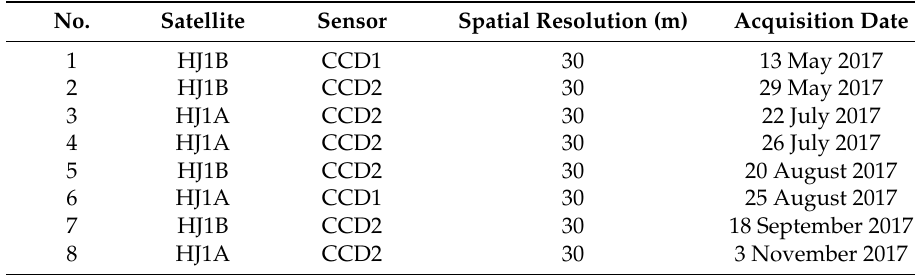
Table 1. Acquisition of remote sensing data.